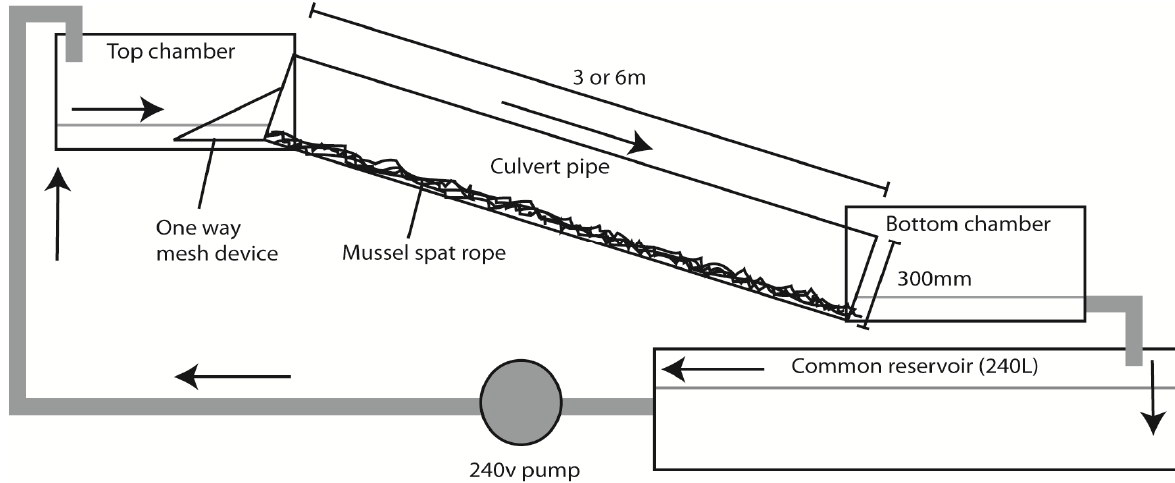
Figure 1. Schematic diagram of experimental culvert system assessing the effects of mussel spat rope on passage success of redfin bully Gobiomorphus huttoni . Figure illustrates one of the treatment systems with mussel spat rope attached. Each 3 or 6 m length was paired with treatment (rope) and control systems which were run through trials without rope. Arrows indicate direction of